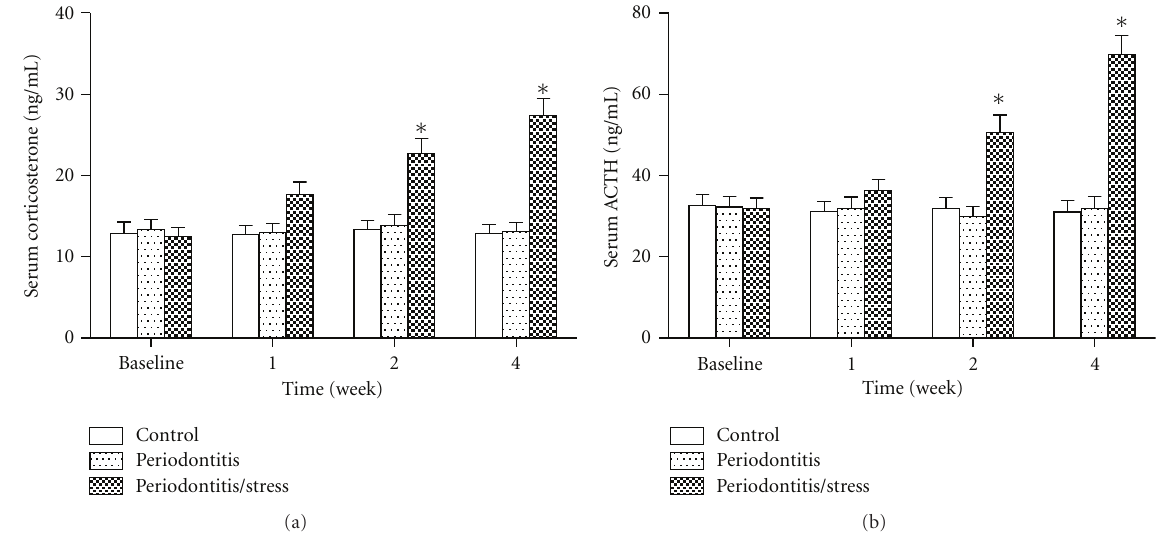
Figure 4: Serum corticosterone level (a) and serum ACTH level (b) of the rats in all groups. (cid:0) P